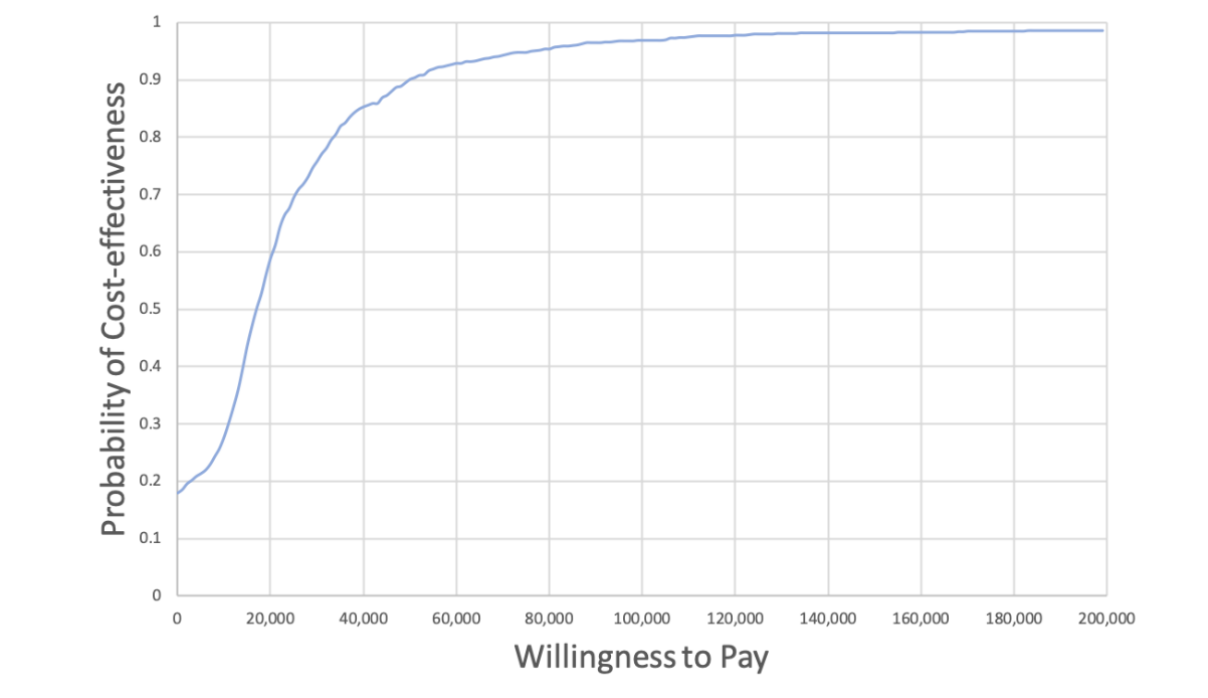
Figure 4. Cost-effectiveness acceptability curve of reference case probabilistic